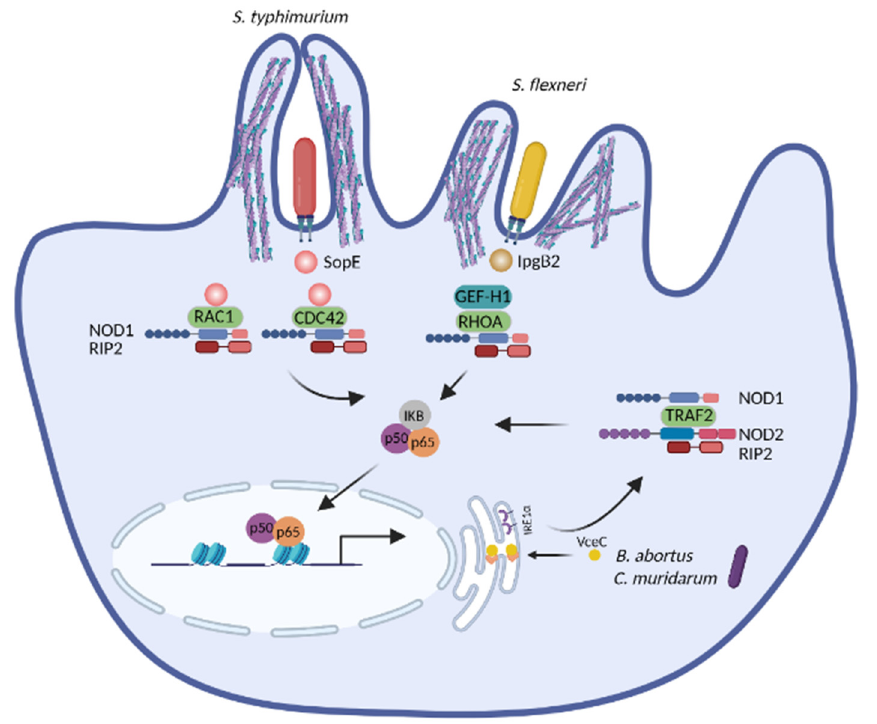
Figure 4. NOD1 and NOD2 trigger NF- κ B activation by detecting pathogen-induced cytoskeleton disruption or pathogen-induced ER stress. Virulence factors from S. typhimurium and S. flexneri induce aberrant actin polymerization, subsequently triggering NOD1-mediated NF- κ B activation. B. abortus and C. muridarum elicit ER stress, which is further sensed by NOD1 and NOD2 to enable NF- κ B activation. Abbreviations: RHOA, Ras homolog family member A; CDC42, cell division control protein 42 homolog; RAC1, Ras-related C3 botulinum toxin substrate 1; GEF-H1, guanine nucleotide exchange factor H1; TRAF2, TNF receptor associated factor 2; RIP2, receptor-interacting-serine/threonine-protein kinase 2; IKB, inhibitor of κ B; IRE1 α , inositol-requiring enzyme-1a; IpgB2, invasion plasmid gene B2; SopE, Salmonella outer protein E; VceC, virB-coregulated effector C. Image created with BioRender.com